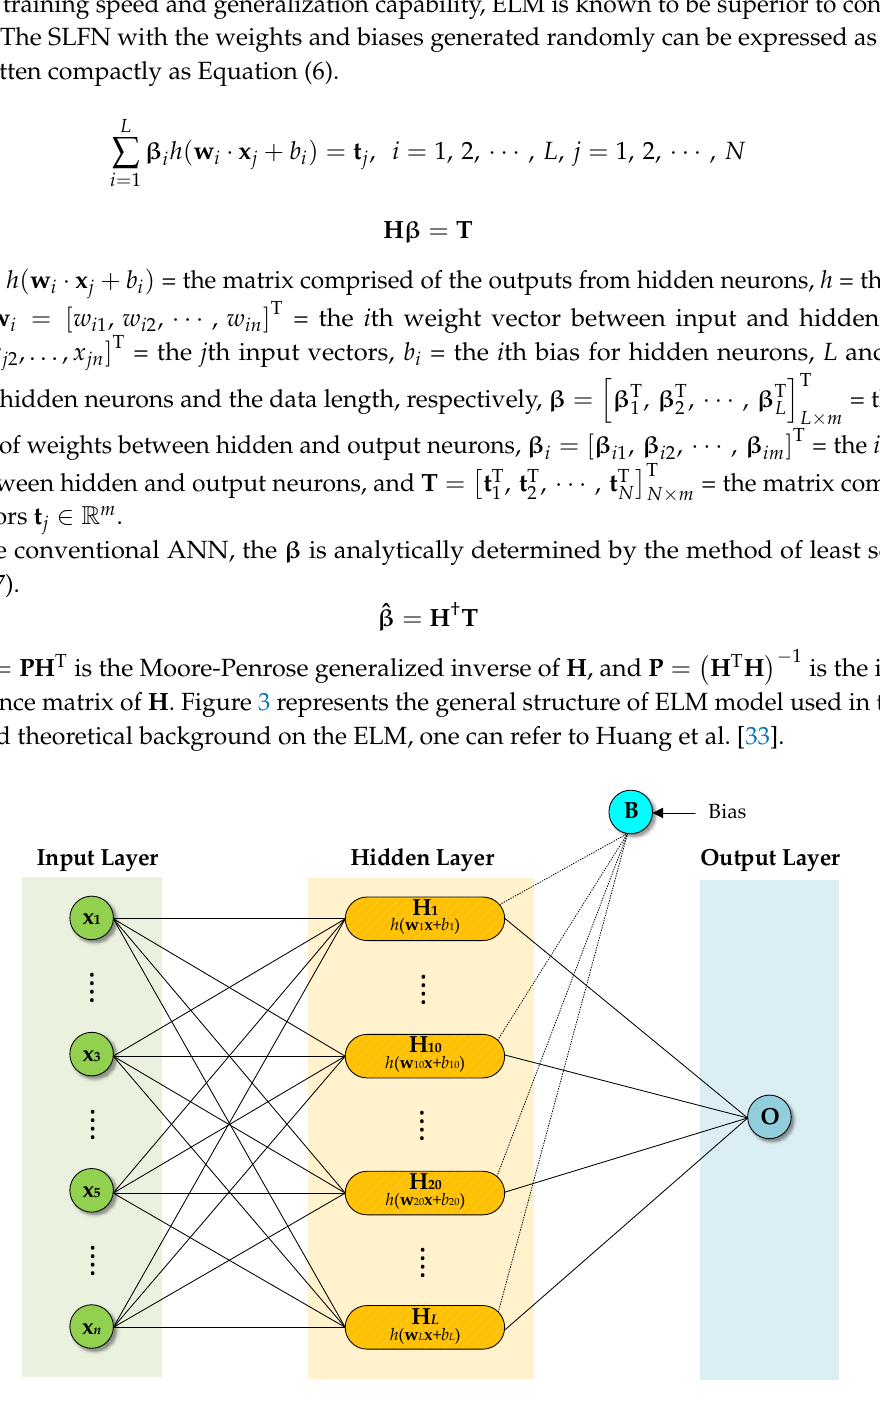
Figure 3. General structure of extreme learning machine (ELM).